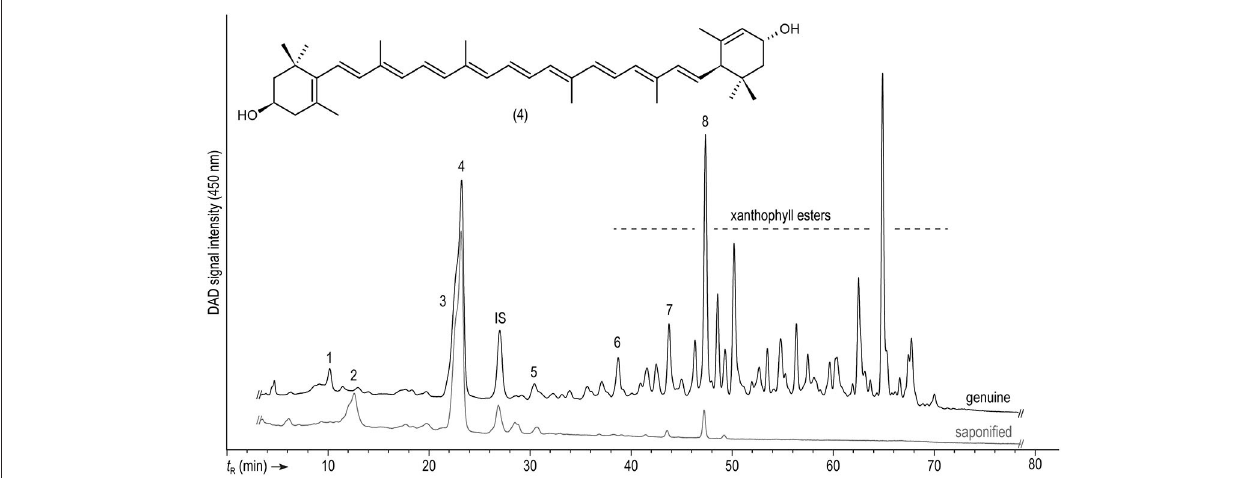
FIGURE 3 | Representative HPLC-DAD separation of carotenoids and chlorophylls in genuine and saponified extracts from the peels of the Anaranjado (orange) variety monitored at 450nm. For peak assignment, see Table 5 .